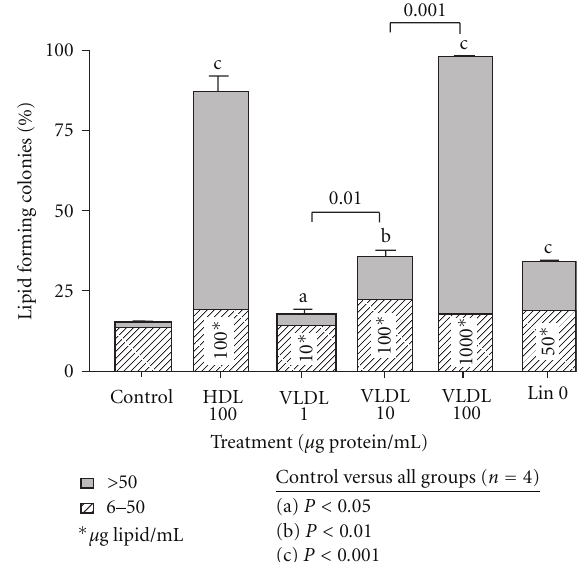
Figure 3: Comparison of protein versus lipid content of HDL, VLDL, and LIN on induction of sebocyte di ff erentiation. VLDL was more potent than HDL in the induction of sebocyte di ff erentiation in terms of protein content but less potent when comparing lipid content ( n = 4). Means +/ − SEMs are